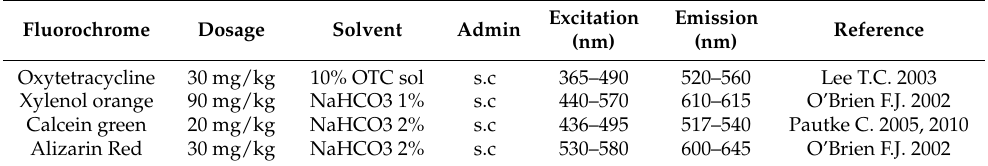
Table 3. Overview of the four applied fluorochromes including administration, dosage, and spectral details with excitation and emission wavelengths and references. The confocal laser microscope settings for fluorescence signal capture are based on the author’s experience and previous works on polychrome labelling in bone tissue engineering research